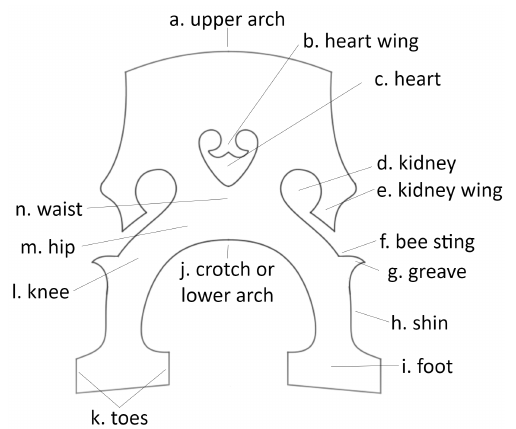
Figure A1. Outline of a French cello bridge and the names of the different